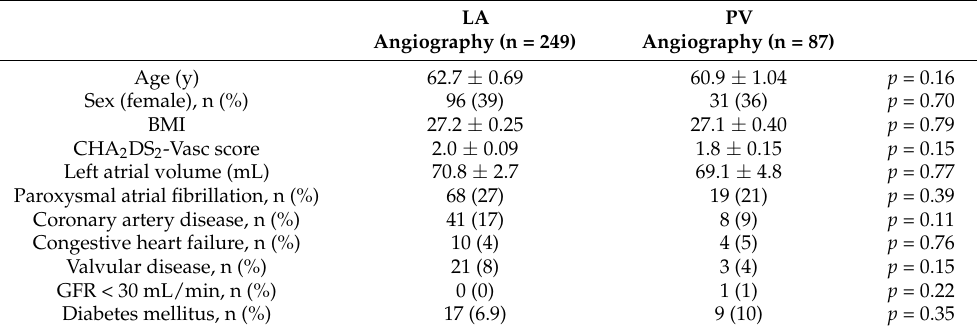
Table 1. Baseline patient